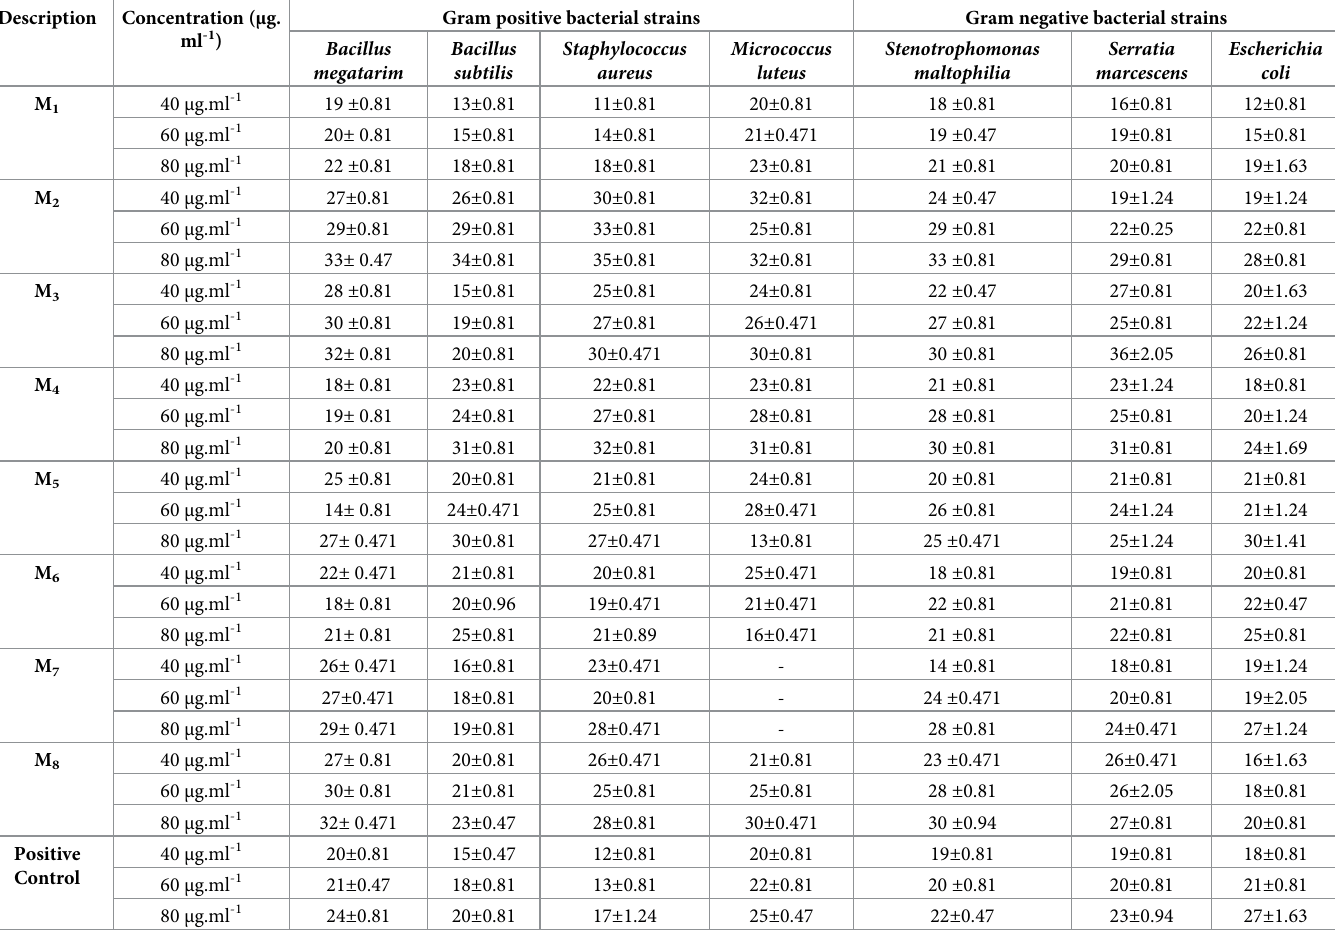
Table 1. The results of antibacterial studies were determined and tabulated against gram-positive and gram-negative bacterial strains. Description Concentration ( μ g. ml -1